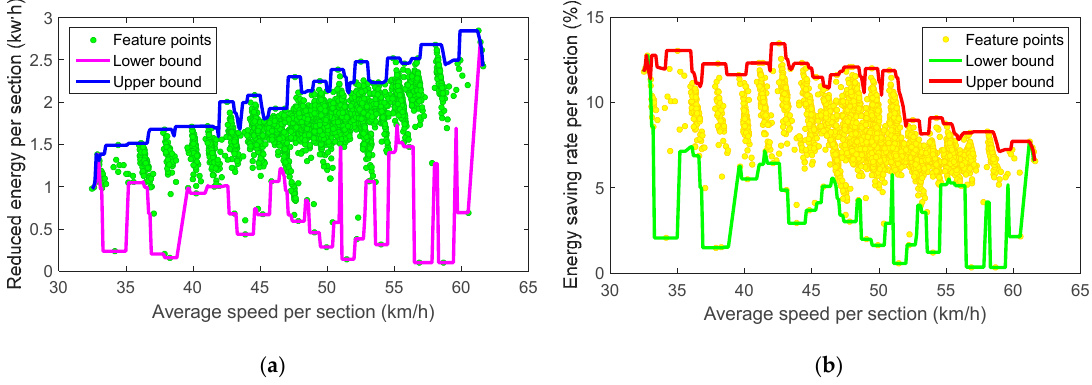
Figure 11. Boundaries of ASS-REN-PLF and ASS-RER-PLF profiles (weekday, TQ-SH, N p = 773). ( a ) ASS-REN-PLF profile result; ( b ) ASS-RER-PLF profile result.